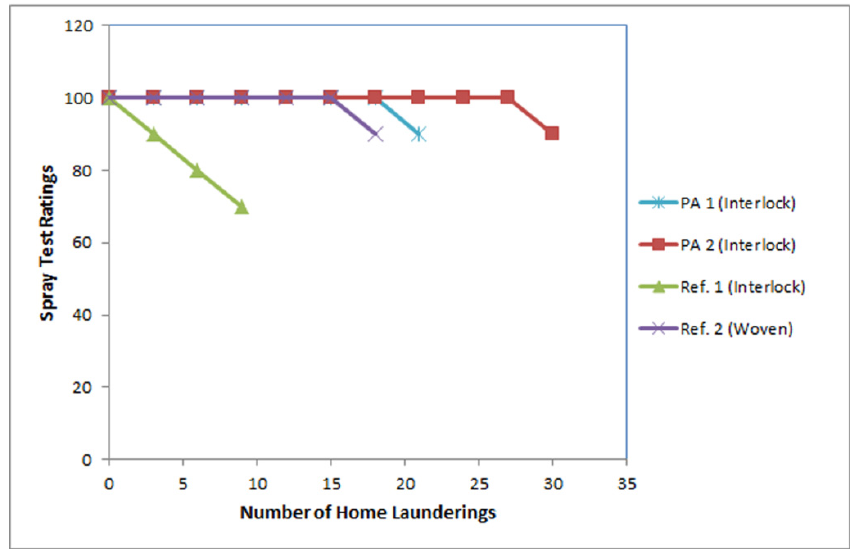
Figure 7. Comparison of spray test of treated fabric and commercial